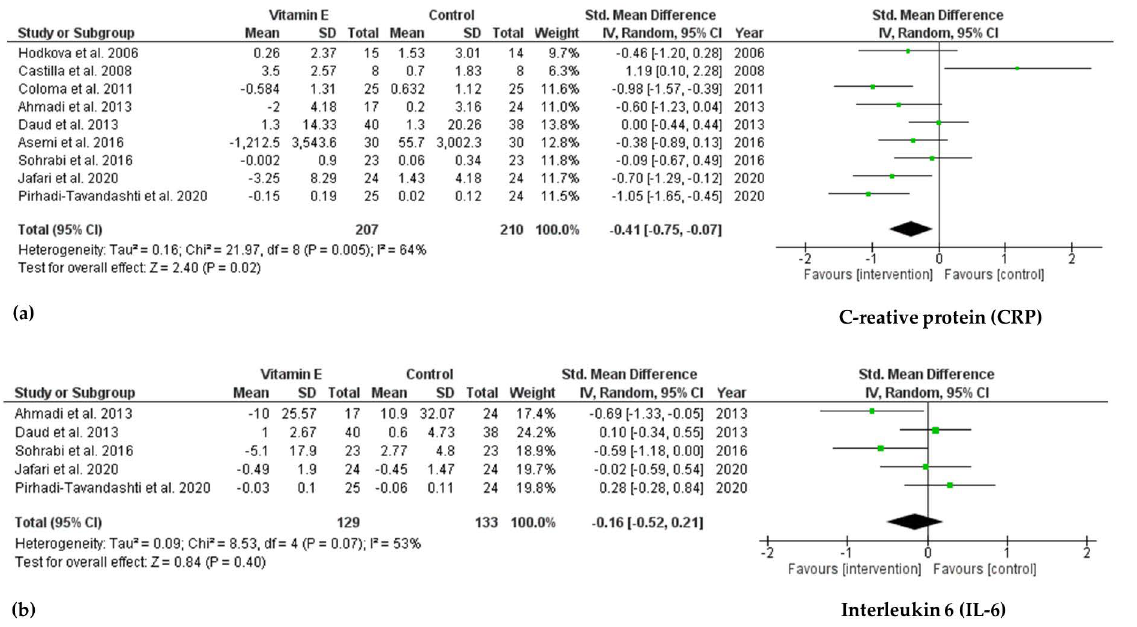
Figure 4. Forest plot for effect of vitamin E supplementation on biomarkers of inflammation ( a ) Creative protein (CRP) and ( b ) Interleukin 6 (IL-6) in hemodialysis